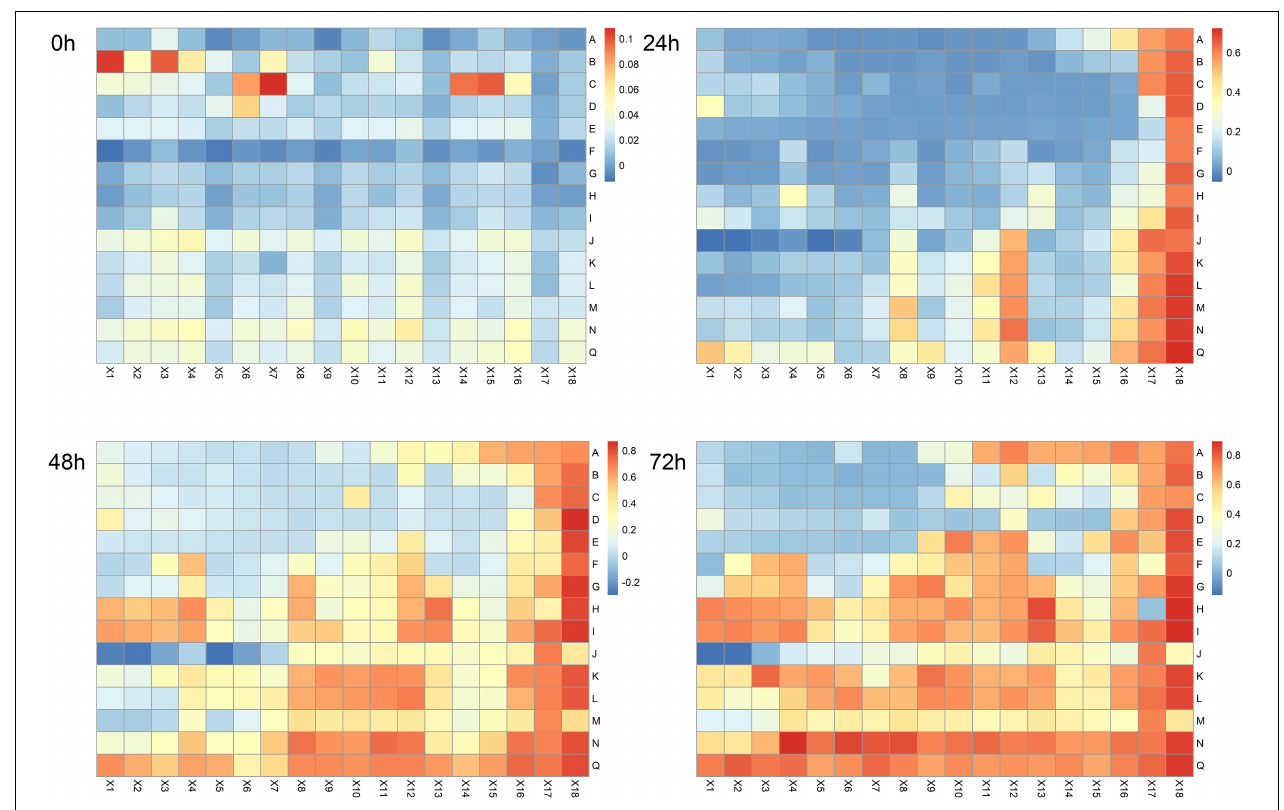
FIGURE 2 | Heatmap of antibacterial effects of binary combination treatments at 0, 24, 48, and 72 h. Bars shown on the right of each map represent OD values. Blue and red indicate low and high levels of OD values, respectively. A, phloretin – ferulic acid; B, phloretin – p -coumaric acid; C, phloretin – caffeic acid; D, phloretin – (–)-epigallocatechin; E, phloretin – chlorogenic acid; F, ferulic acid – p -coumaric acid; G, ferulic acid – caffeic acid; H, ferulic acid – (–)-epigallocatechin; I, ferulic acid – chlorogenic acid; J, p -coumaric acid – caffeic acid; K, p -coumaric acid – (–)-epigallocatechin; L, p -coumaric acid – chlorogenic acid; M, caffeic acid – (–)-epigallocatechin; N, caffeic acid – chlorogenic acid; Q, (–)-epigallocatechin – chlorogenic acid; X1, 1 mg/mL and 1 mg/mL; X2, 1 mg/mL and 0.5 mg/mL; X3, 1 mg/mL and 0.25 mg/mL; X4, 1 mg/mL and 0.125 mg/mL; X5, 0.5 mg/mL and 1 mg/mL; X6, 0.5 mg/mL and 0.5 mg/mL; X7, 0.5 mg/mL and 0.25 mg/mL; X8, 0.5 mg/mL and 0.125 mg/mL; X9, 0.25 mg/mL and 1 mg/mL; X10, 0.25 mg/mL and 0.5 mg/mL; X11, 0.25 mg/mL and 0.25 mg/mL; X12, 0.25 mg/mL and 0.125 mg/mL; X13, 0.125 mg/mL and 1 mg/mL; X14, 0.125 mg/mL and 0.5 mg/mL; X15, 0.125 mg/mL and 0.25 mg/mL; X16, 0.125 mg/mL and 0.125 mg/mL; X17, solvent control; X18, NB medium control. The intersections of rows and columns represent binary combination (A–Q) with corresponding concentrations